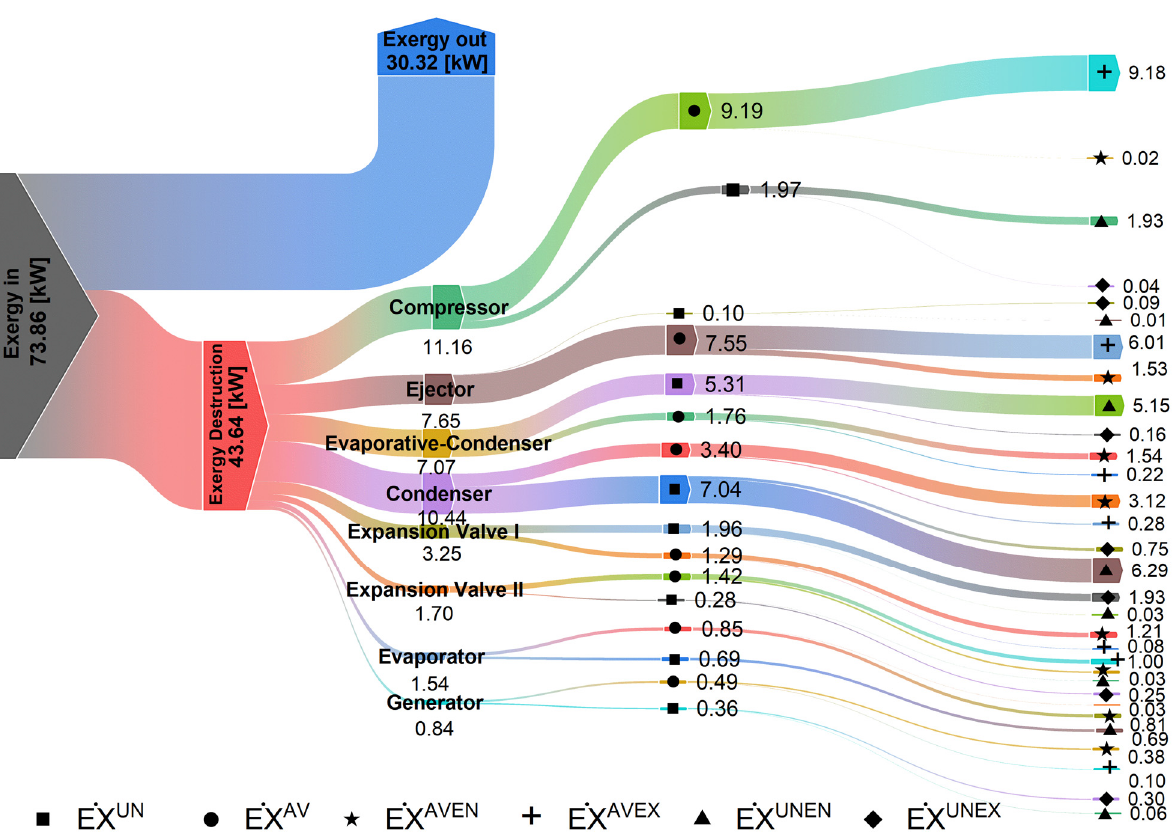
Figure 8. Sankey diagram of exergy flow.